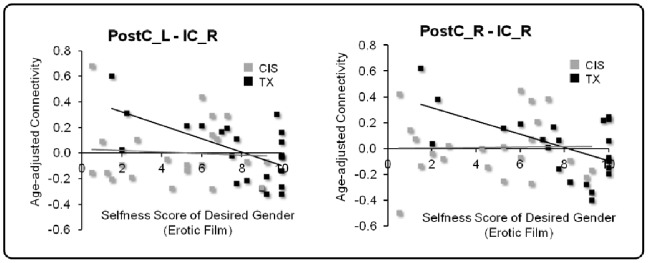
Regression analysis.The connectivity (i.e., the weight of the edge and z score) between the right Post and IC as well as the left Post and right IC are plotted against the selfness score that the TX participants rated for the characters with their identified genders. In the TX group, the connectivity showed a significant negative correlation with the selfness score (right PostC: r = −.57, p<.005; left PostC: r = −.60, p<.005).